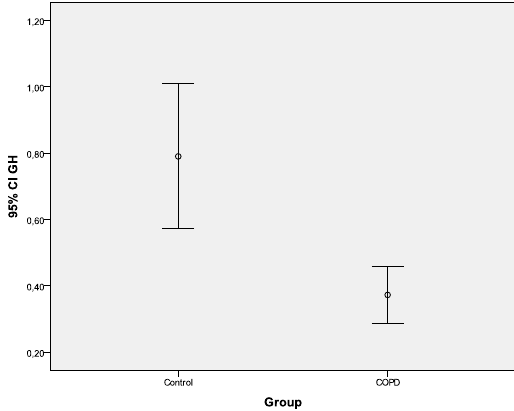
Figure 3. Mean GH values in the control and COPD group.